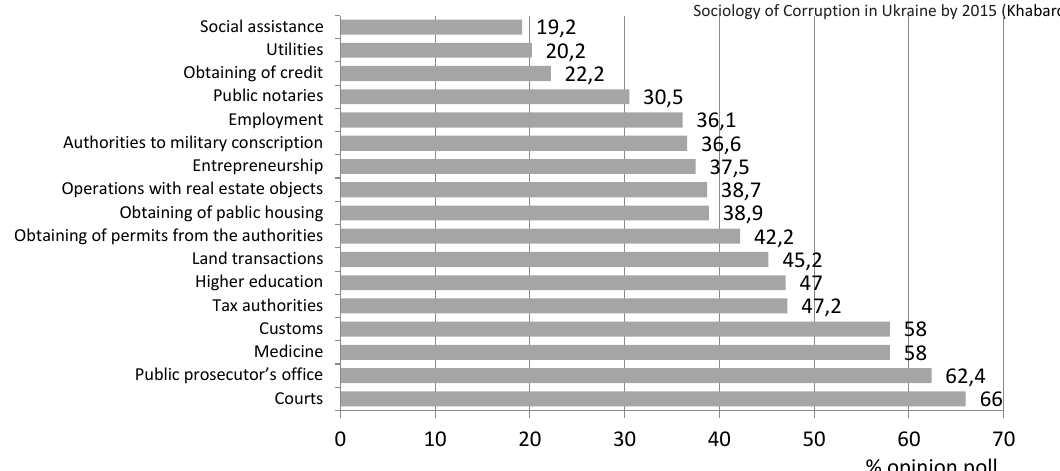
Figure 2. Rating of the most corrupt sectors of activity in